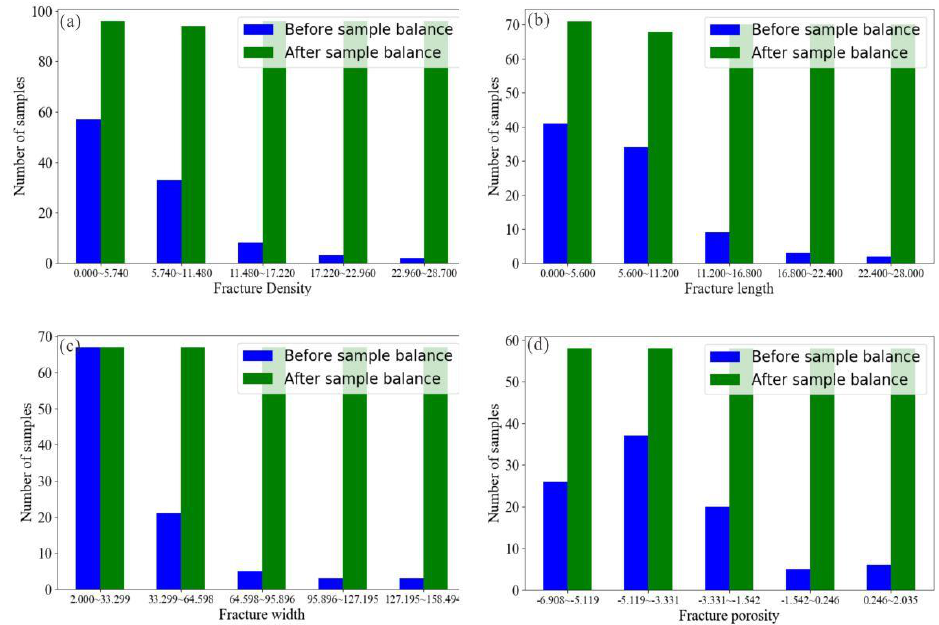
Figure 3. Modelling samples and data points after sample balance. ( a ) Fracture density; ( b ) Fracture length; ( c ) Fracture width; ( d ) Fracture